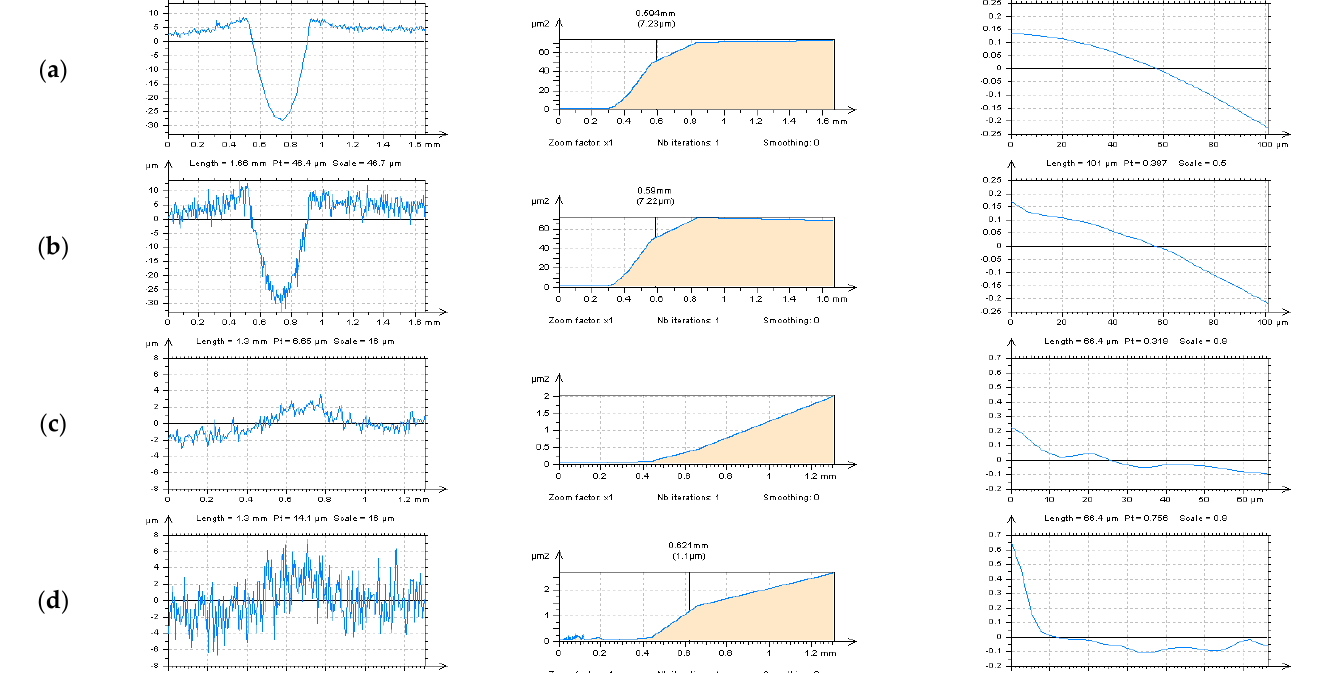
Figure 2. Profiles (left column), their PSDs (middle), and ACFs (right column), respectively, extracted from the turned cylindrical surface containing dimples by the horizontal ( a , b ) and treatment trace ( c , d )